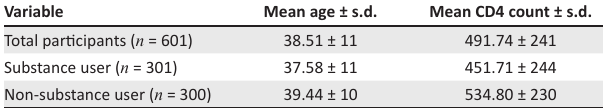
TABLE 2: Baseline demographic characteristics of the study participants. Variable Substance use Non-substance